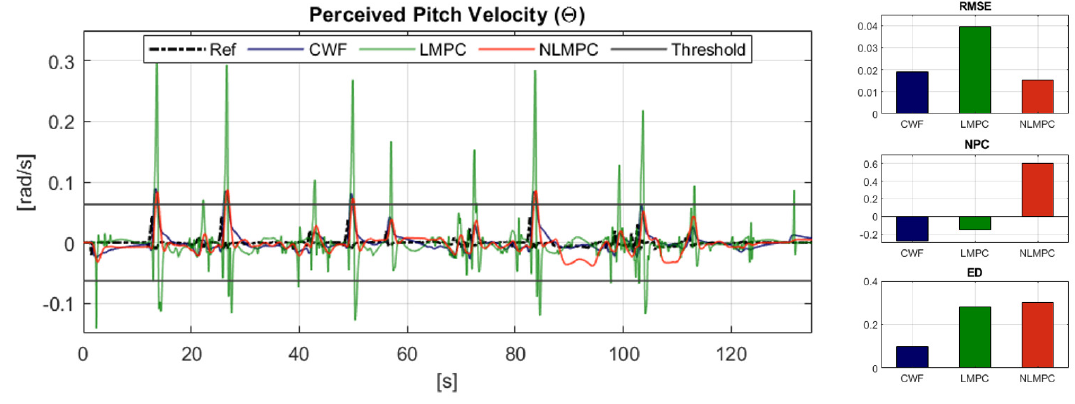
Figure 13. Reference Tracking performance: Perceived Pitch Velocity.